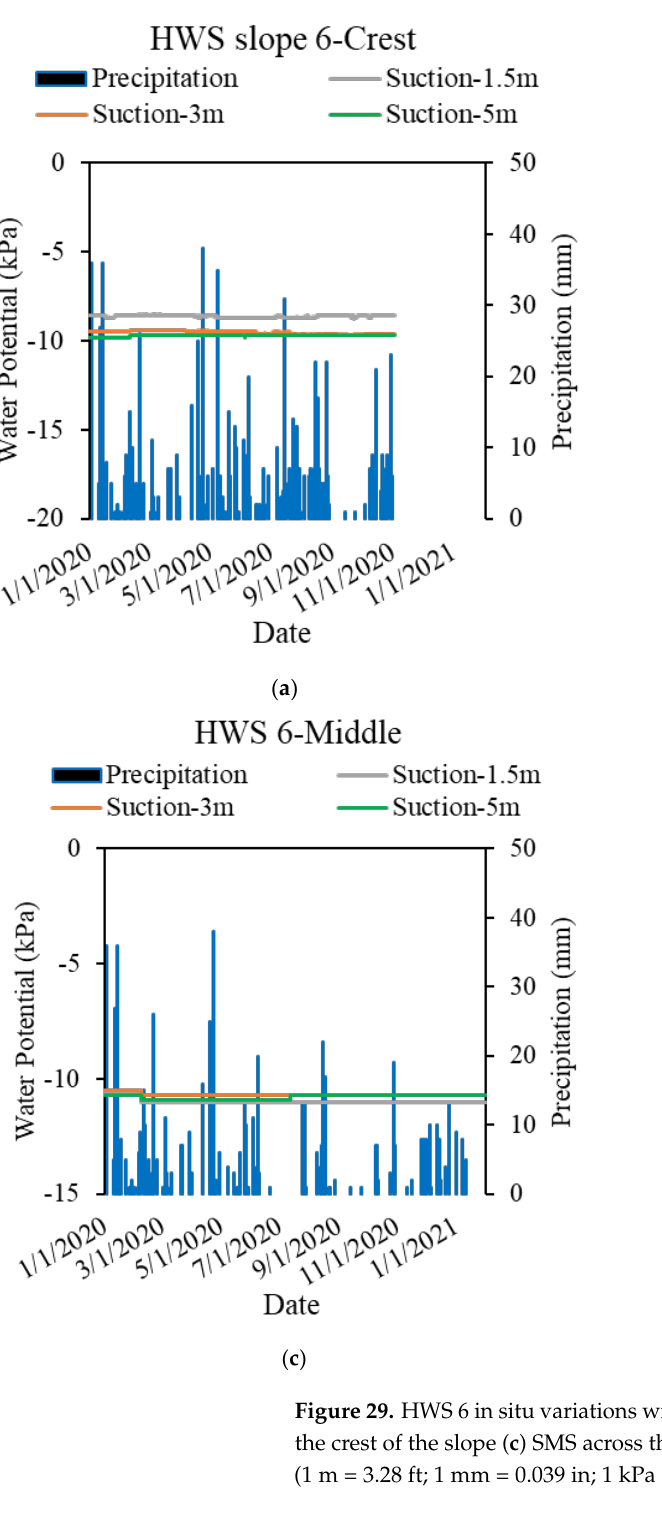
30 Figure 28. HWS 6 ERI and instrumentation layouts along with its characteristics (drone image-top view) ( 1′ = 1 ft = 0.305 m). 6.6.1. Instrumentation Layout Similar to the previously mentioned HWS, in each of the instrumentation locations, at 5 ft (1.5 m), 10 ft (3 m) and 15 ft (5 m) depths on HWS6, a moisture sensor and a water potential sensor were installed. Additionally, a rain gauge and air temperature sensor- were installed at Instrumentation 1 at slope 6 (Figure 5). Variations of in situ VSMC and SMS profiles at 5 ft (1.5 m), 10 ft (3 m) and 15 ft (5 m) depths with rainfall at the three instrumentation locations are presented in Figure 29. Based on the field monitoring re- sults, the SMS has a high number for around three months and then reached an equilib- rium condition. SMS values observed were low and did not change much over the course of the monitoring period, similar to other HWS. VSMC also showed low variations throughout the monitoring period, except during late 2020 and early 2021. As observed from the ERI results shown in Figure 30, the soil is likely to be close to a fully saturated condition. Therefore, VSMC and SMS did not show many variations. The SMS varied with time only at the 5 ft (1.5 m) depth of all the HWS except for HWS 5, where significant SMS variation was observed at the middle of the slope as well (Figure 24). Following a brief decline in SMS potential at shallow depths, SMS values re- bounded during the summer. This correlated to a decrease in the VSMC level at 5 ft (1.5 m) depth during the summer months because of decreased rainfall and increased temper- atures. This suggests that in the slope soil layers (Yazoo clay) upper unsaturated zone, an inverse relationship exists between VSMC and SMS. However, there were no significant changes in SMS or VSMC associated with rainfall at depths of around 10 ft (3 m) and 15 ft